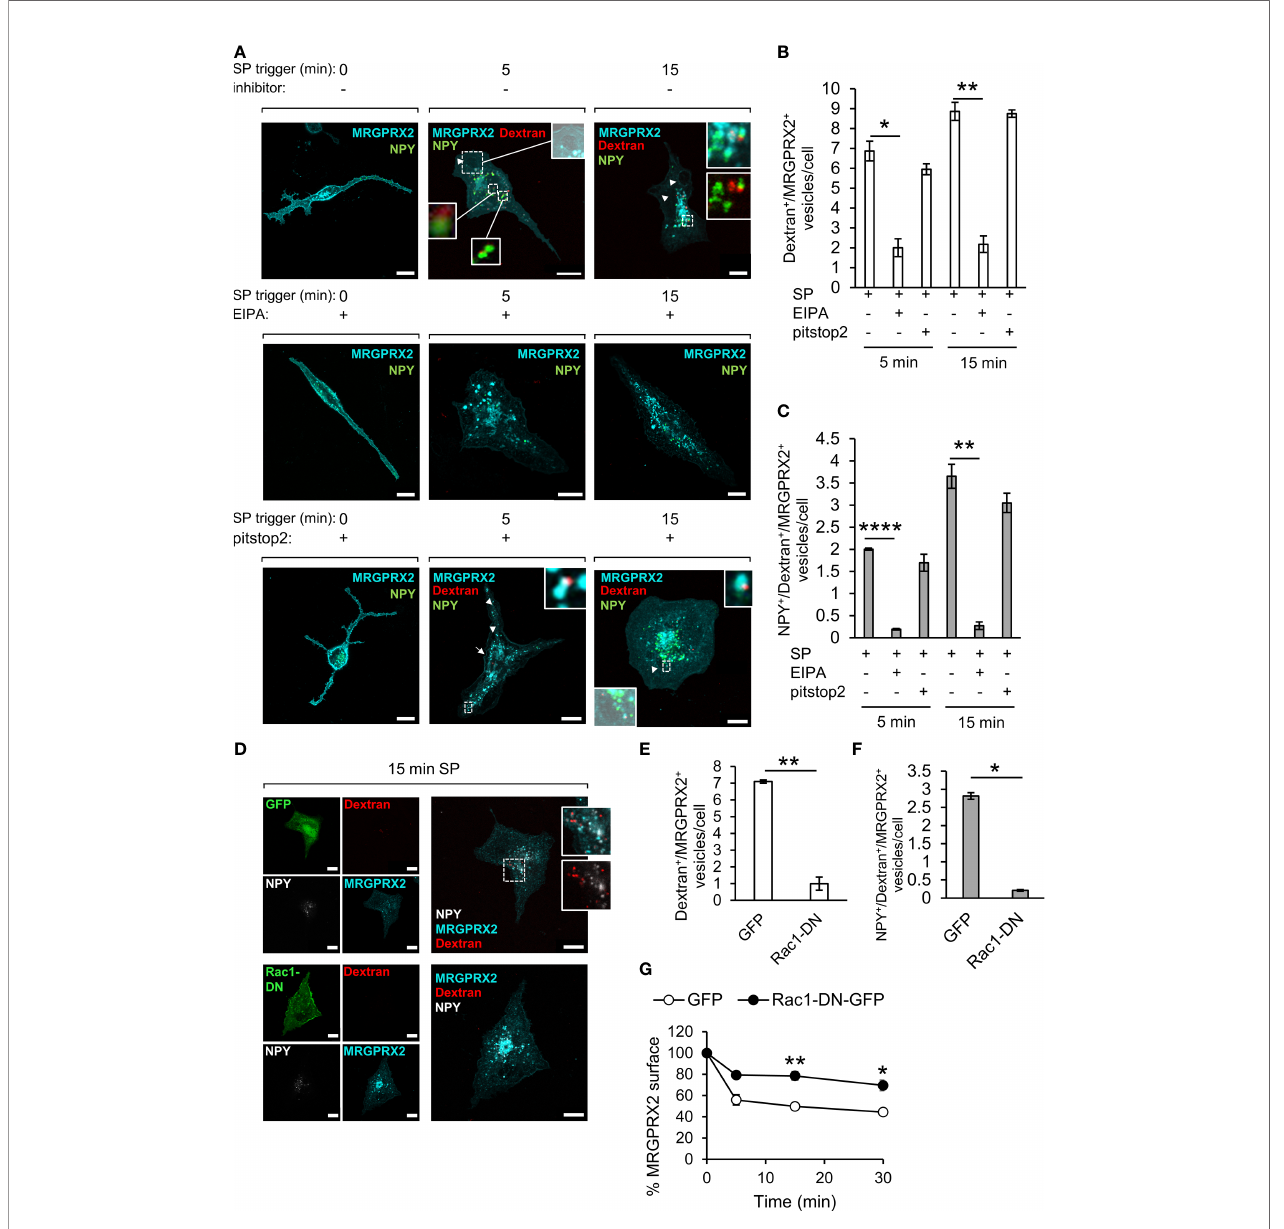
FIGURE 3 | MRGPRX2 internalizes by macropinocytosis. RBL-MRGPRX2 cells, transiently transfected with NPY-Venus (green) (A) , or co-transfected with NPY-CFP (pseudo colored white) and either GFP or Rac1-DN-GFP (green) (D) , were triggered with 10 µM SP in the presence of 0.1 mg/ml TRITC-Dextran (red) for the indicated time periods, in the presence of vehicle (A, D) or following 30 min pre-incubation with either 50 µM EIPA or 20 µM pitstop2, as indicated (A) . Cells were immunostained with anti-HA antibodies followed by Alexa Fluor ® 647-conjugated secondary antibodies (pseudo colored cyan). Enlargements correspond to the boxed areas. Macropinosomes are shown as the overlap with the bright fi eld images. Arrows point to MRGPRX2 position at sites of macropinosome formation and arrowheads point to macropinosomes. Scale bars = 10µm. The mean number of vesicles/cell that are double positive for Dextran and MRGPRX2 (Dextran + /MRGPRX2 + ) (B, E) , or triple positive for NPY, Dextran and MRGPRX2 (NPY + /Dextran + /MRGPRX2) (C, F) , was calculated for cells that were triggered for the indicated time periods with SP (15 min for E and F ), in the absence or presence of the indicated inhibitors or Rac1-DN. Results are means ± SEM from three (D – F, G) or four (A – C) independent experiments, with each experiment including 15-20 cells/condition. The effect of Rac1-DN expression on SP-induced internalization of MRGPRX2 was quanti fi ed by fl ow cytometry, by measuring the cell surface amount of MRGPRX2 gated on GFP-positive single cells. Results are presented as the percentage of the amount of cell surface MRGPRX2 in the absence of stimulation by SP (G) . Data are means ± SEM of four independent experiments. Statistical signi fi cance was determined by unpaired two-tailed Welch ’ s t-test. P values for Dextran + / MRGPRX2 + vesicles/cell: * P [5 min: SP vs. SP+ EIPA] = 0.0271, ** P [15 min: SP vs. SP + EIPA] = 0.0026, ** P [GFP vs. Rac1-DN-GFP] = 0.009. P values for NPY + / Dextran + /MRGPRX2 + vesicles/cell: ** P [15 min: SP vs. SP + EIPA] = 0.01, **** P [5 min: SP vs. 5 min SP + EIPA] = 2.996x10^6, * P [GFP vs. Rac1-DN-GFP] = 0.018. P values for MRGPRX2 surface expression are ** P [5 min: SP/GFP vs. SP/Rac1-DN-GFP] = 0.01, * P [15 min: SP/GFP vs. SP/Rac1-DN-GFP] =